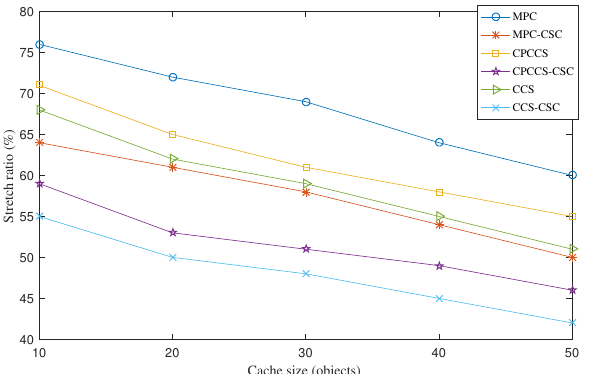
Figure 2. Average stretch ratio of MPC, MPC-CSC, CPCCS, CPCCS-CSC, CCS, and CCS-CSC under various cache sizes.